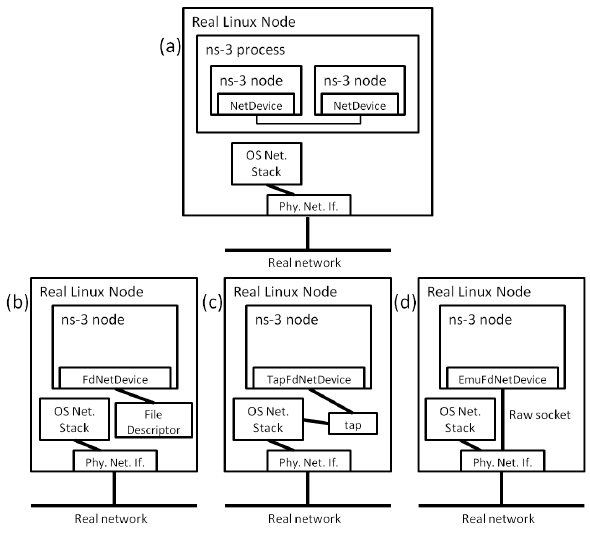
Figure 2: Overview of the communications pro- vided by the ns-3 (a)NetDevice, (b)FdNetDevice, (c)TapFdNetDevice and